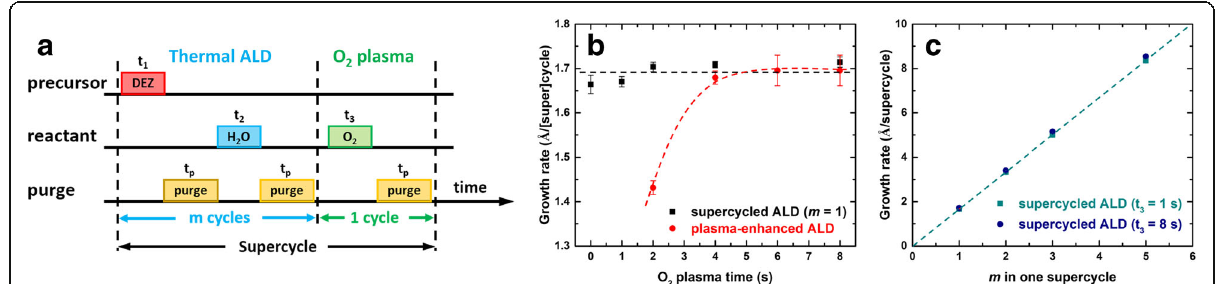
Fig. 1 a Illustration of the one growth supercycle of the proposed supercycled ALD process. b ZnO growth rates as a function of the O 2 plasma time for supercycled ALD with fixed thermal cycle ( m = 1) and plasma-enhanced ALD processes; the dashed curves are guides of the eye. c ZnO growth rate and linear fitting as a function of the thermal process cycle m with fixed O 2 plasma times ( t 3 = 1 and 8